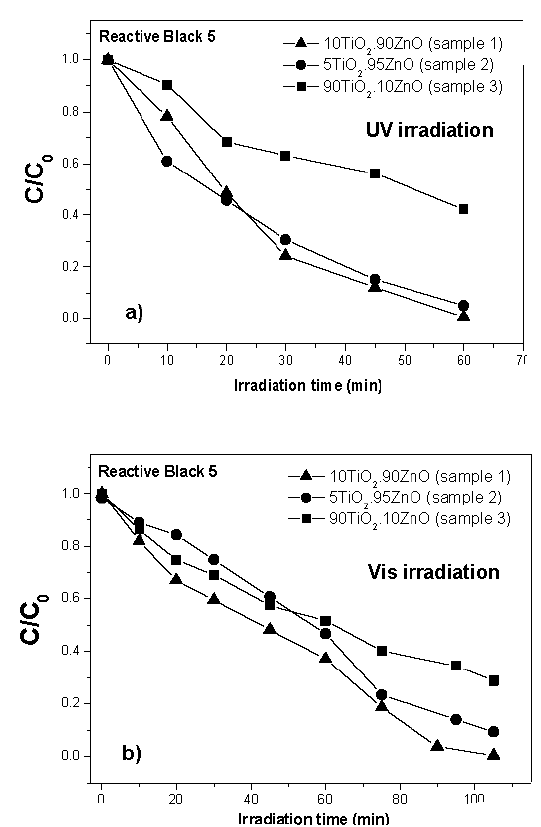
Figure 7. Photocatalytic degradation of Malachite Green (MG) by the investigated samples under UV (a) and Vis (b)